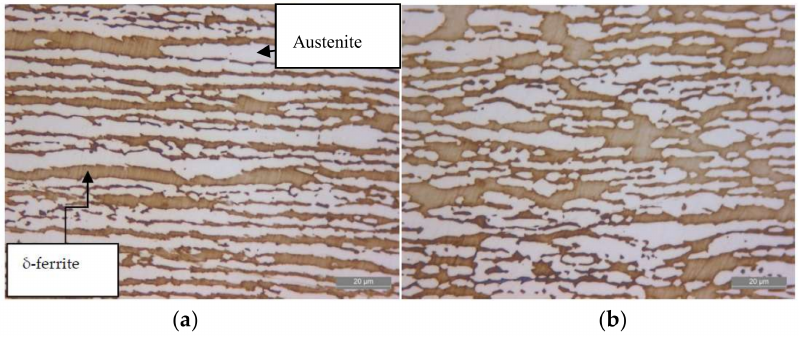
Figure 1. Base metal (unwelded specimen) microstructures ( a ) longitudinal ( b ) transverse direction (500 × ).